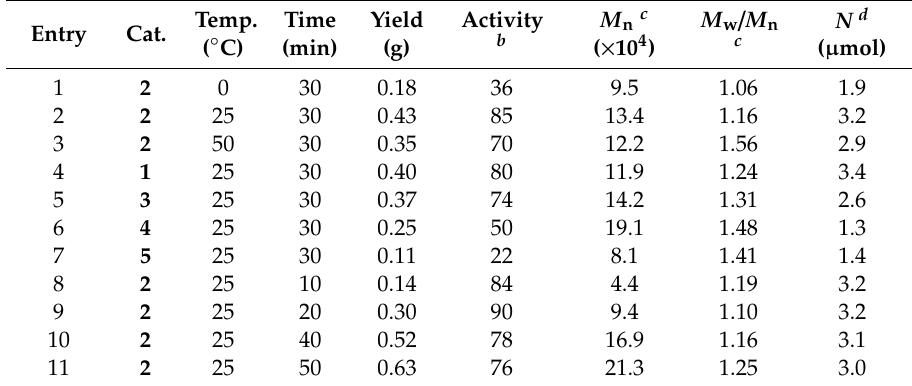
Table 1. Polymerization of propylene with catalysts 1 – 5 . a